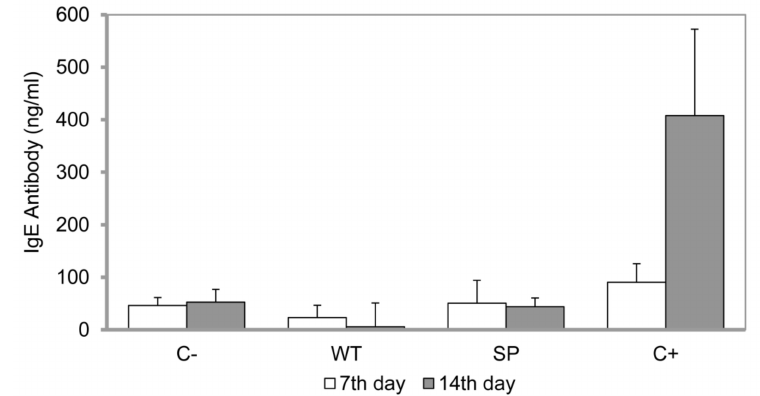
Figure 3. Quantitative analysis of the IgE antibody levels using ELISA for allergenicity assessment. The rats ( n = 3/group) were sensitized with transgenic (SP) and non-transgenic (WT) sugarcane juice, and the accumulations of IgE antibody titers in rat serum were determined by ELISA at 7th and 14th day, thereafter. The IgE antibody levels were presented as means ± SEM (standard error mean). The serum of no treatment rat (C − ) and OVA-sensitized rat (C+) were also analyzed to compare the IgE antibody levels of WT and